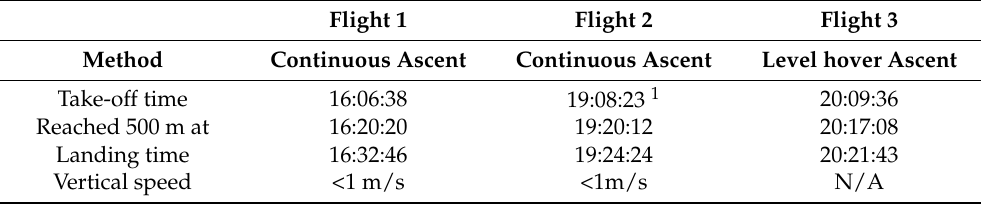
Table 2. Details of individual flights and their characteristics. Times are in local time zone